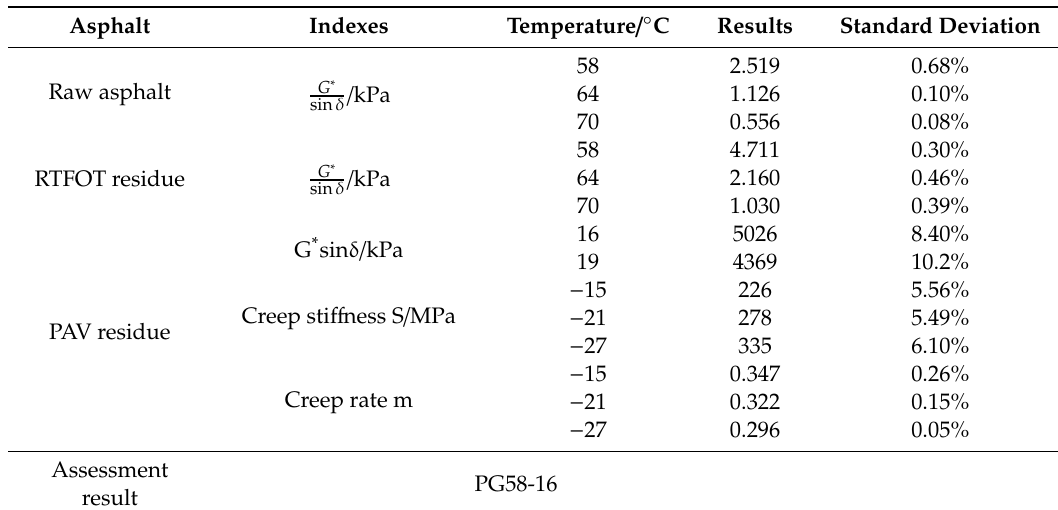
Table 5. PG grade results of MA (matrix asphalt).